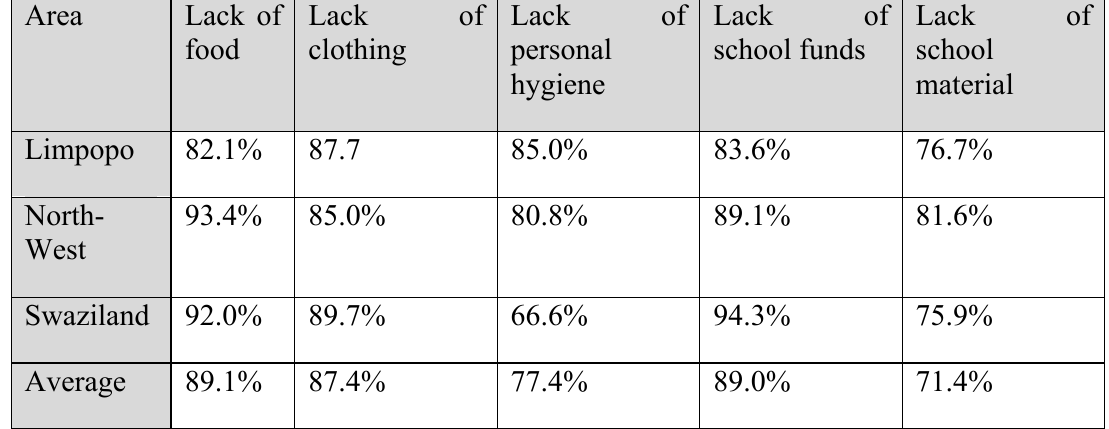
Table 3. Teachers’ perception of orphans’ poverty expressed in lack of